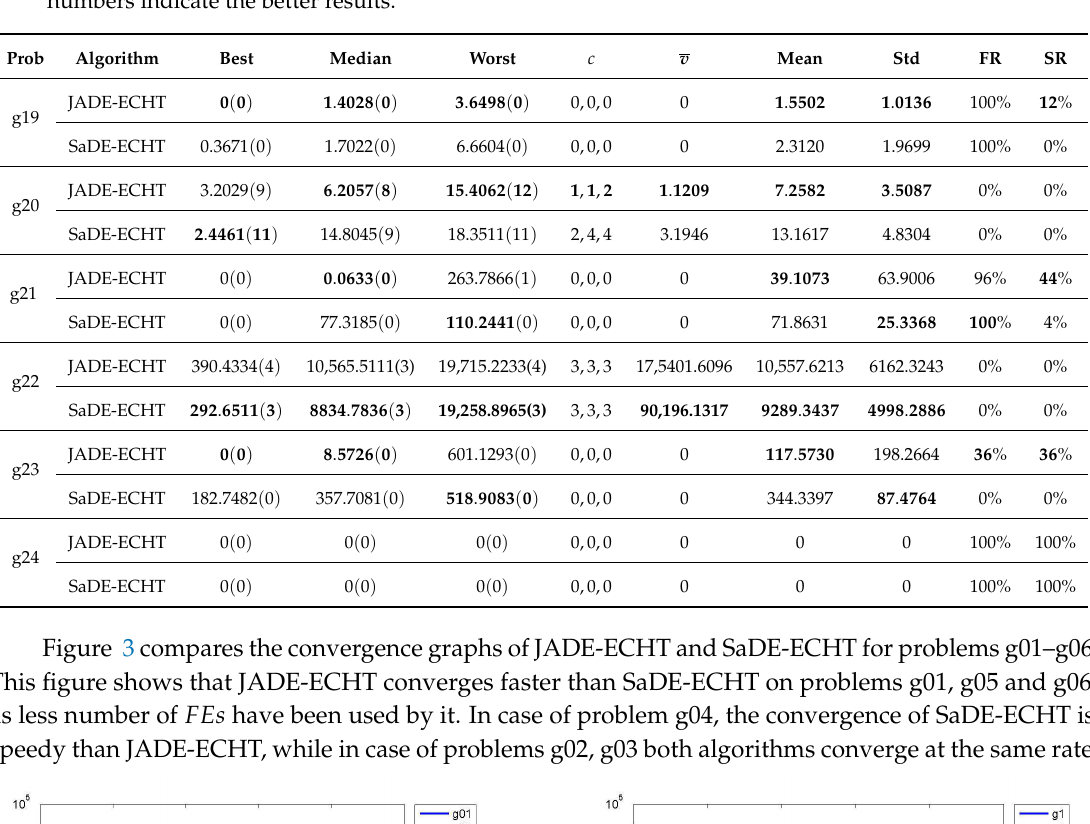
Table 6. Comparison of JADE-ECHT and SaDE-ECHT after FES = 500,000 for g19–g24. The bold numbers indicate the better results.